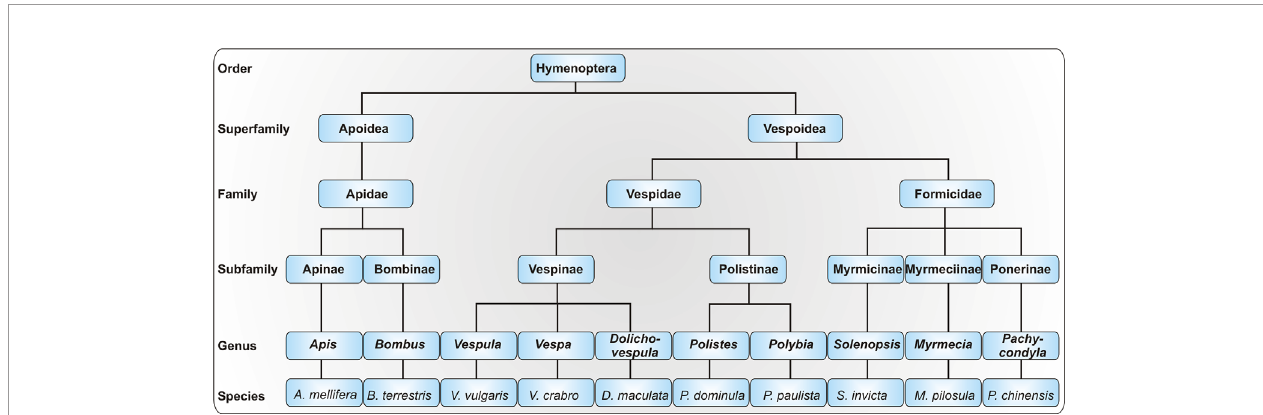
FIGURE 1 | Taxonomy of allergy-relevant Hymenoptera. As the taxonomy of the order Hymenoptera is highly complex, only a selection of allergy-relevant taxa is shown. Displayed are exemplary species with particular relevance for Hymenoptera venom